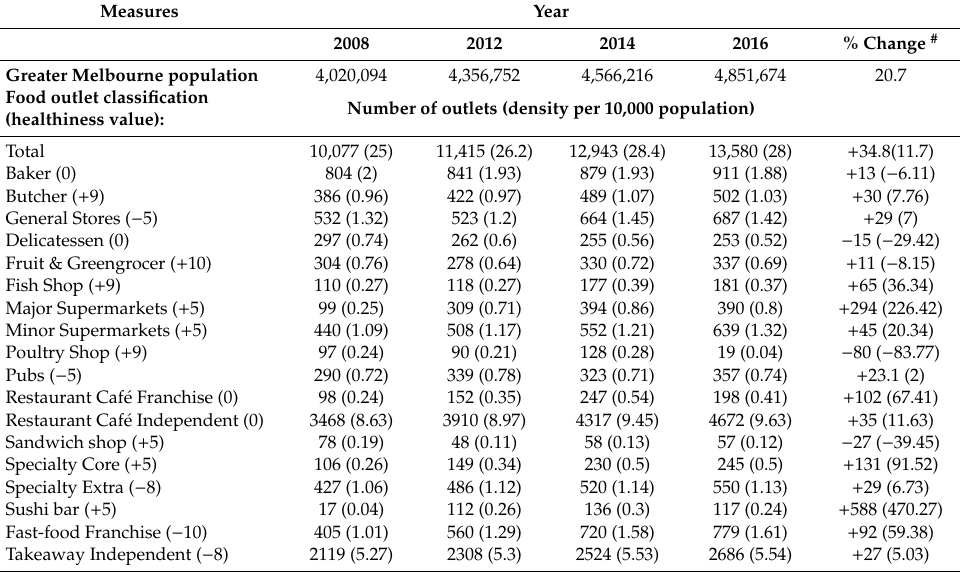
Table 2. Annual resident population estimates, number of food outlets and average density per 10,000 population across Greater Melbourne’s 31 local government areas from 2008 to